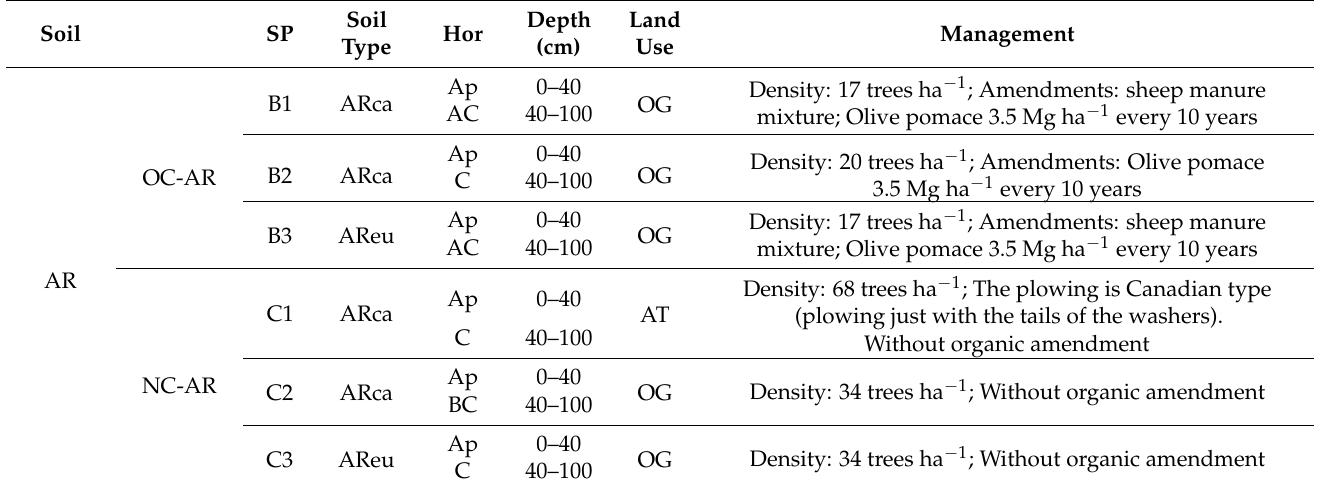
Table 2. Land use, managements, and soil qualifiers of the soils (Arenosols) in the study area.